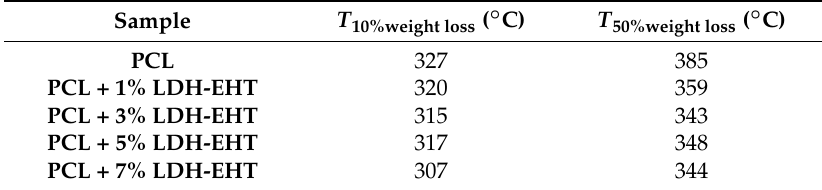
Table 2. Temperature at 10% and 50% of weight loss, extracted from TGA analysis (Figure 4). Sample